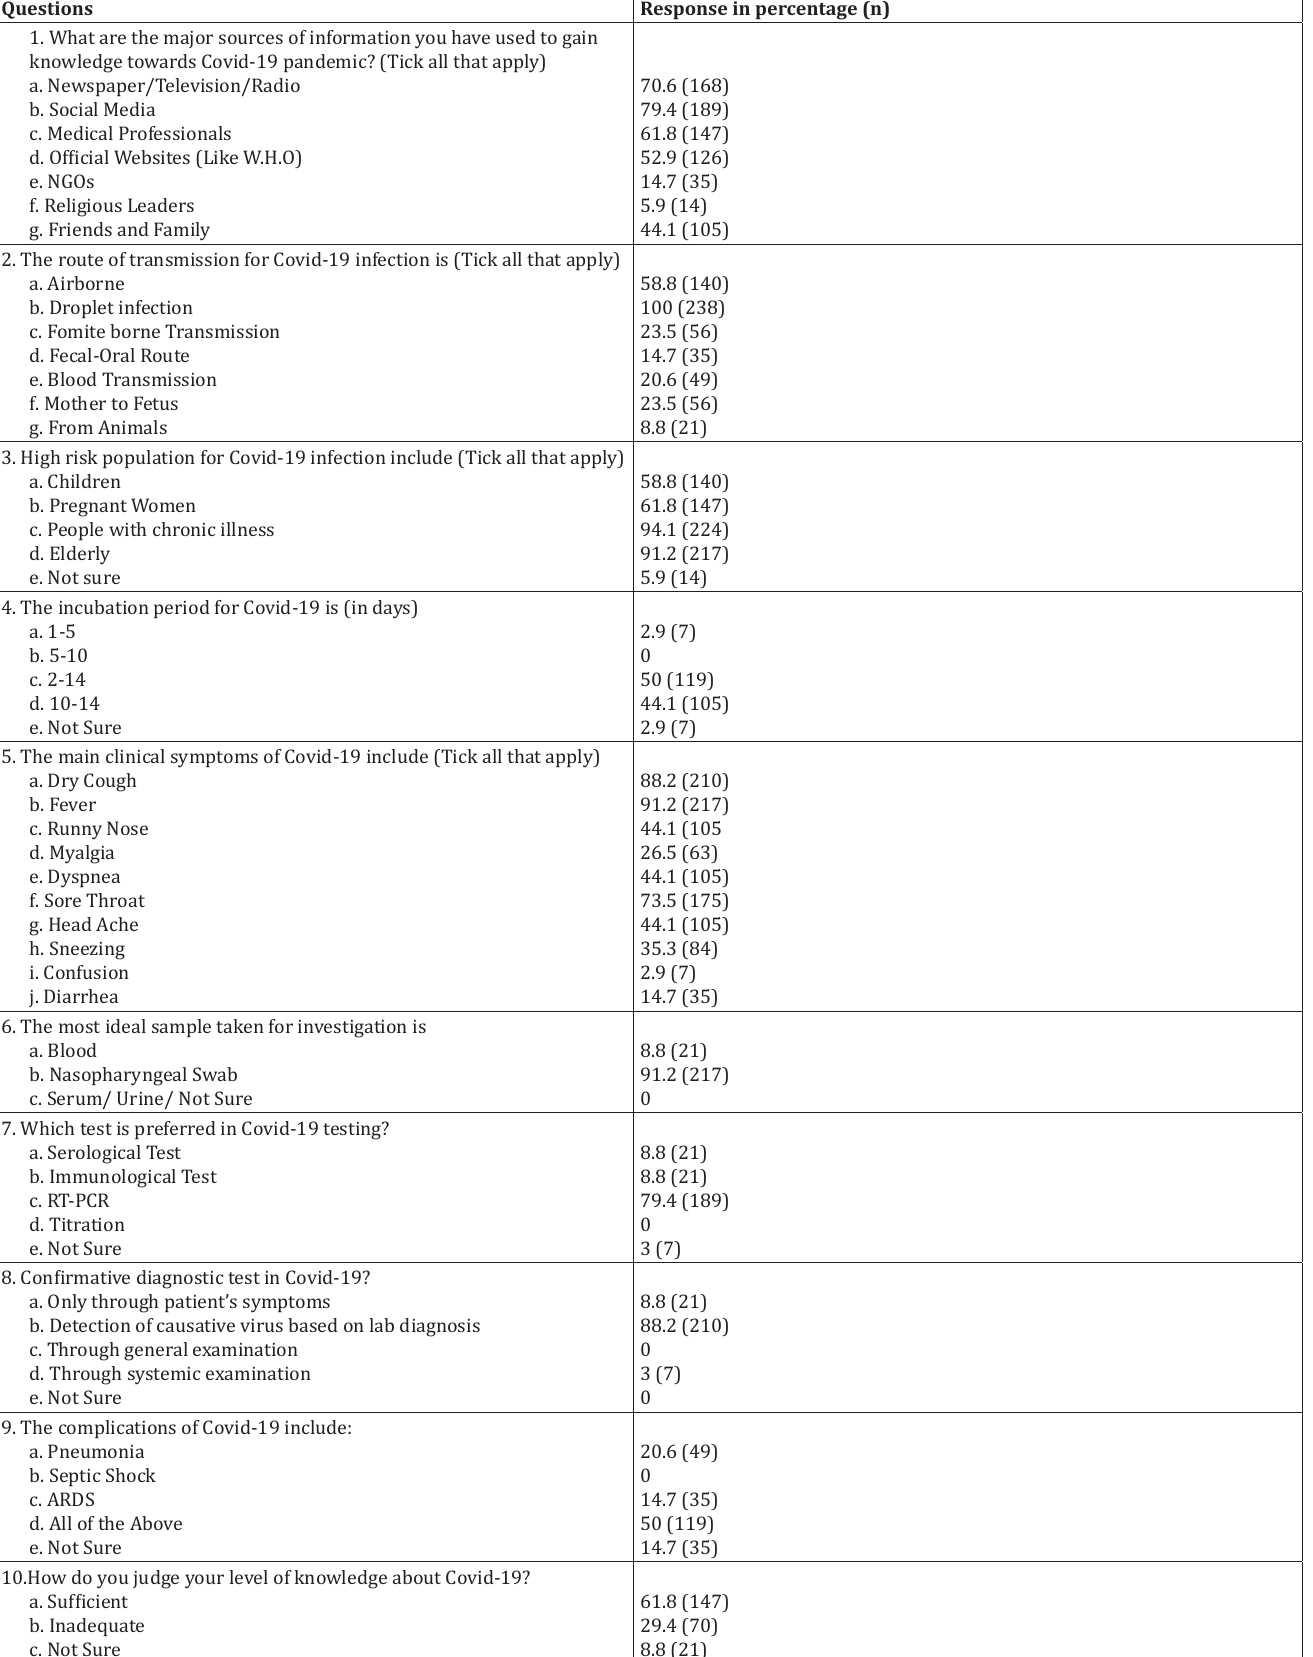
Table 2 Percentage response to knowledge aspect for Covid-19 infection where all choices were